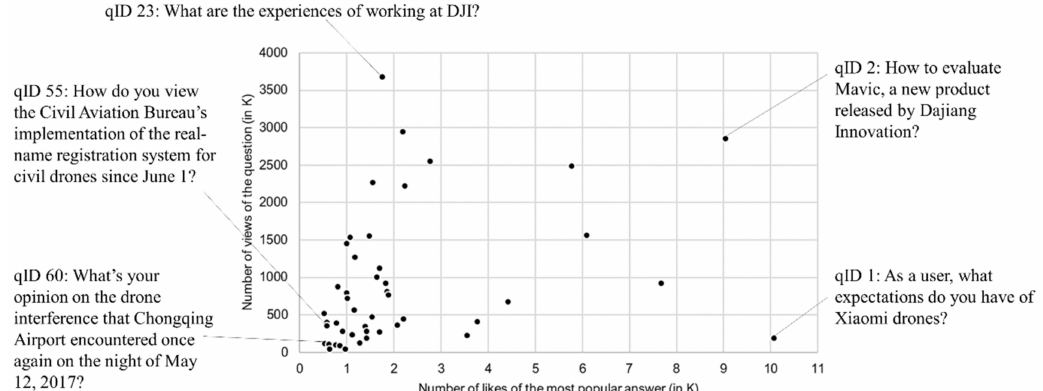
Figure 2. Distribution of the number of views of a question related to the number of likes of the most popular answer. The latter defines the question ranking in the Drone / UAV topic on Zhihu. Some questions are highly viewed, but their answers have a disproportionately low number of